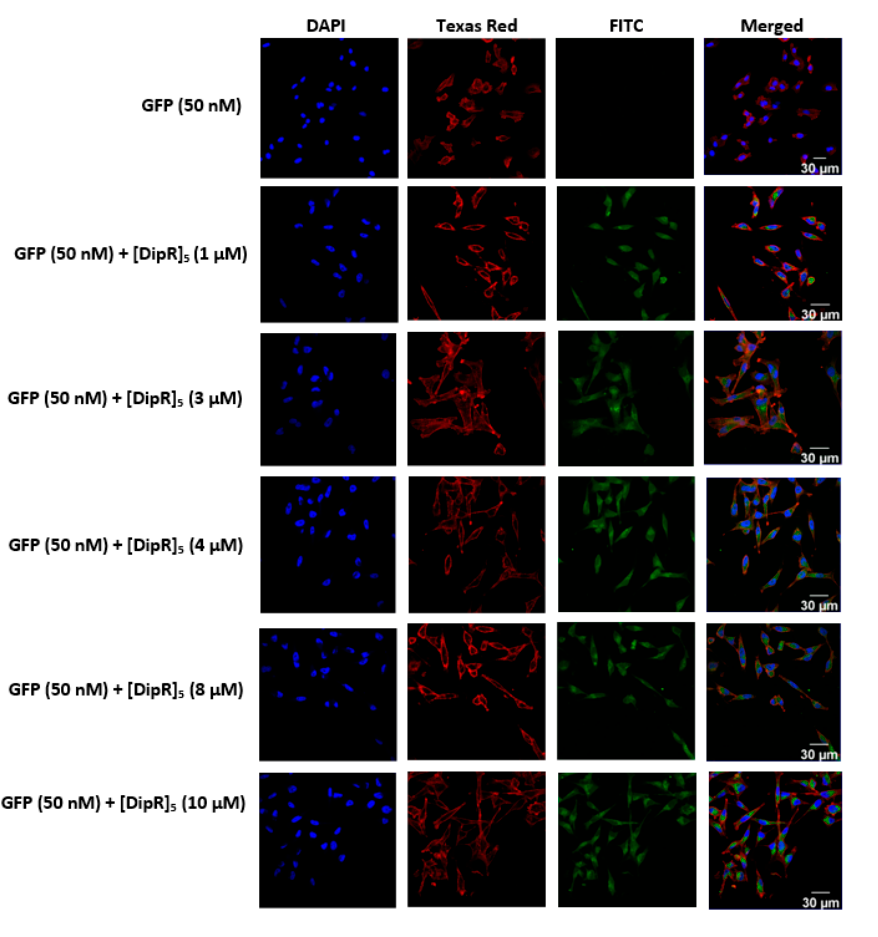
Figure 8. Confocal microscopy images of MDA-MB-231 cells incubated with the GFP-[DipR] 5 mixture at a peptide concentration range (1–10 µM) and GFP at (50 nM) for 3 h. The blue, red, and green channels visualize DAPI (used to stain the nucleus), Texas Red (used to stain the cell membrane), and GFP, respectively.